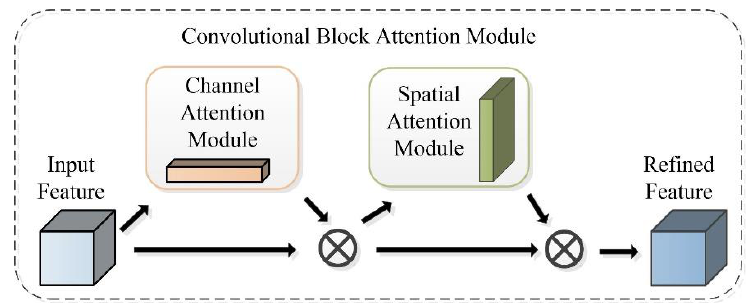
Figure 5. CBAM attention module structure.